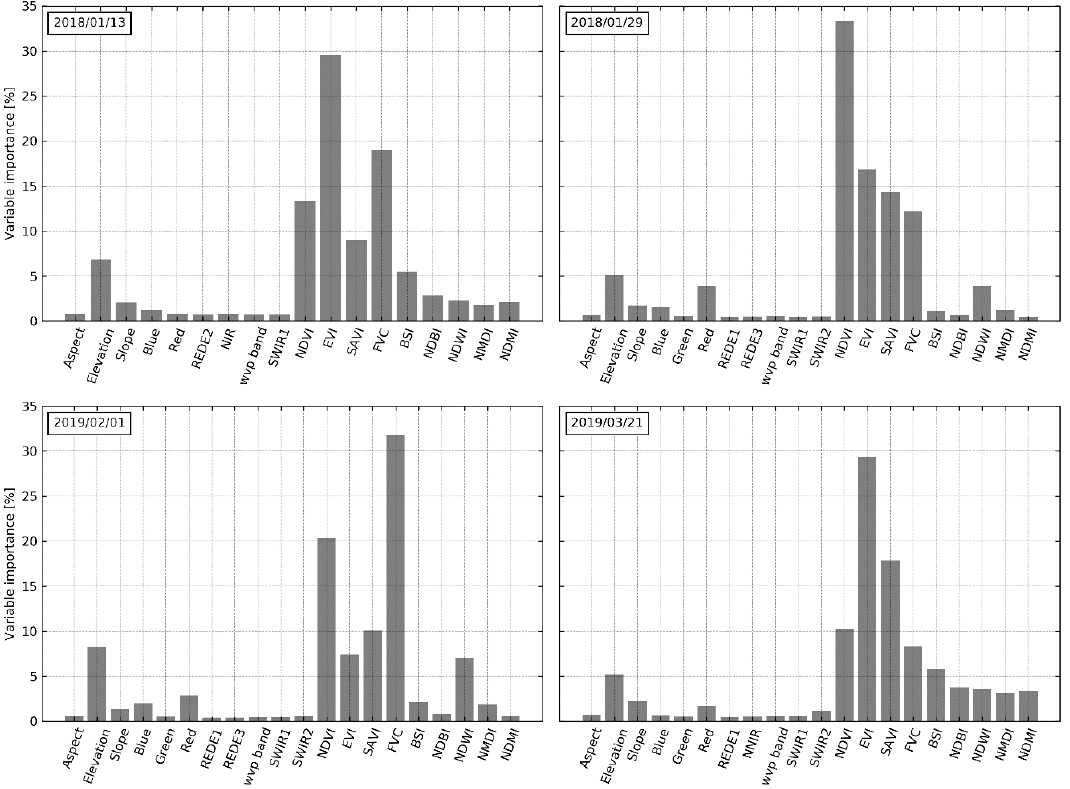
Figure 3. Histograms showing the contribution of each selected predictor variable to the final model for each day corresponding to the four Landsat 8 overpass dates used in the study.